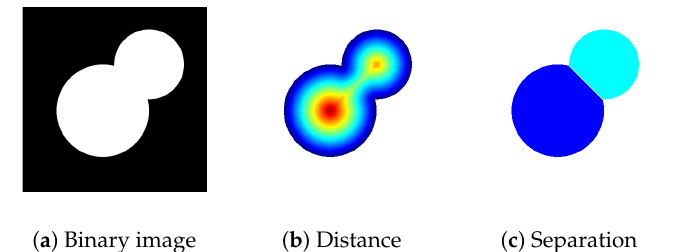
Figure 5. Watershed transform is used to split overlapping cells: ( a ) binary image, ( b ) calculated distance transform, ( c ) afterwards, each pixel is assigned to one of the objects based on belonging to one of the catchment basins.